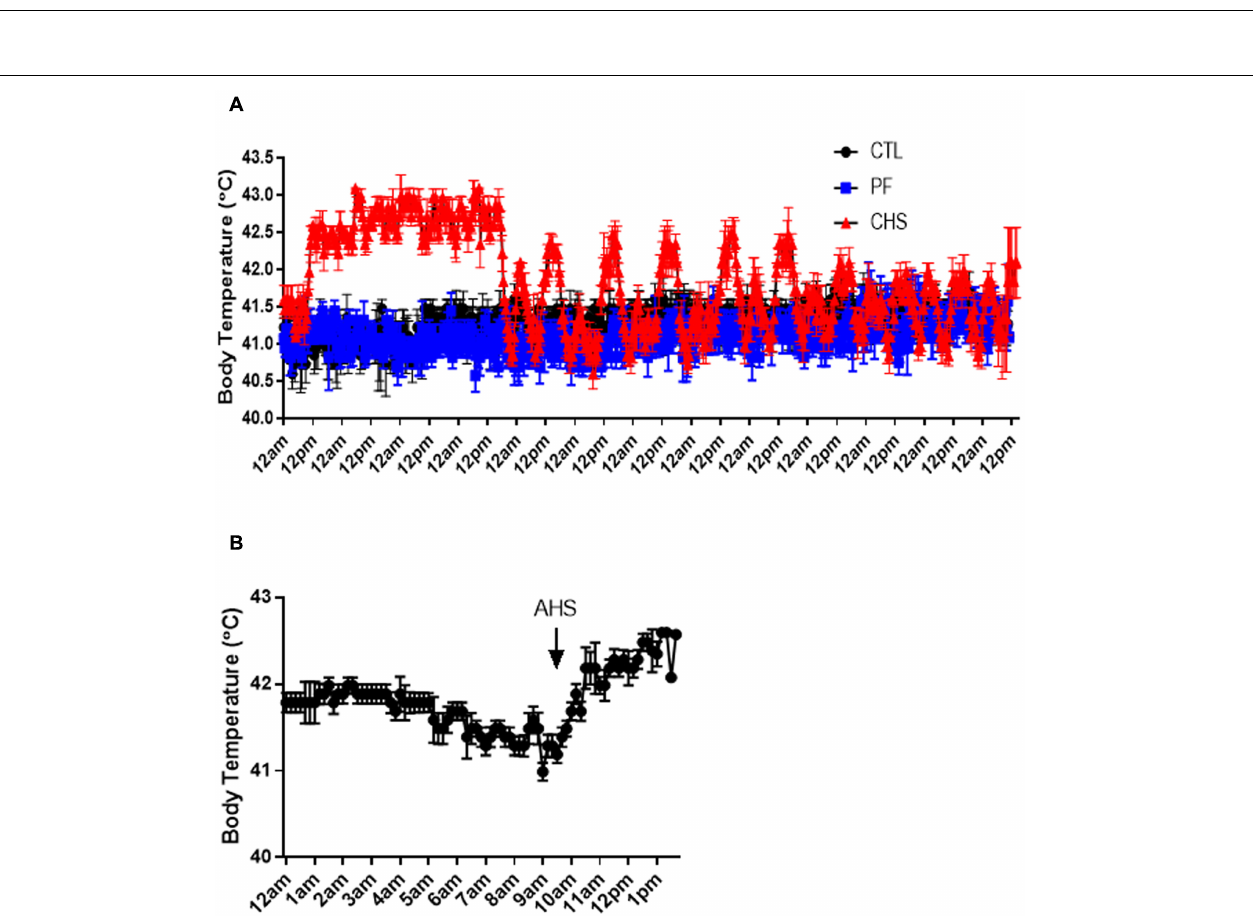
FIGURE 2 | Core body temperature fluctuation during heat stress (HS). (A) Treatments include: (1) control (CTL): birds raised under normal temperature (23 ◦ C) from day 29 to 42 and had free access to the diet; (2) cyclic heat stress (CHS): birds exposed to high temperatures (8 h/day at 35 ◦ C; from 9:30 am to 5:30 pm) from day 29 to 42 and had free access to the diet; (3) pair-fed (PF): birds raised under the same condition as CTL group, but fed the same amount of feed as CHS group from day 29 to 42. (B) Core body temperature fluctuation during an acute heat stress (AHS). Birds in this group raised under thermoneutral condition (23 ◦ C) from day 29 to 42 but exposed to 2 h AHS (35 ◦ C) before sampling on day 42. Data are presented as mean ± SEM ( n = 8; two birds/pen).